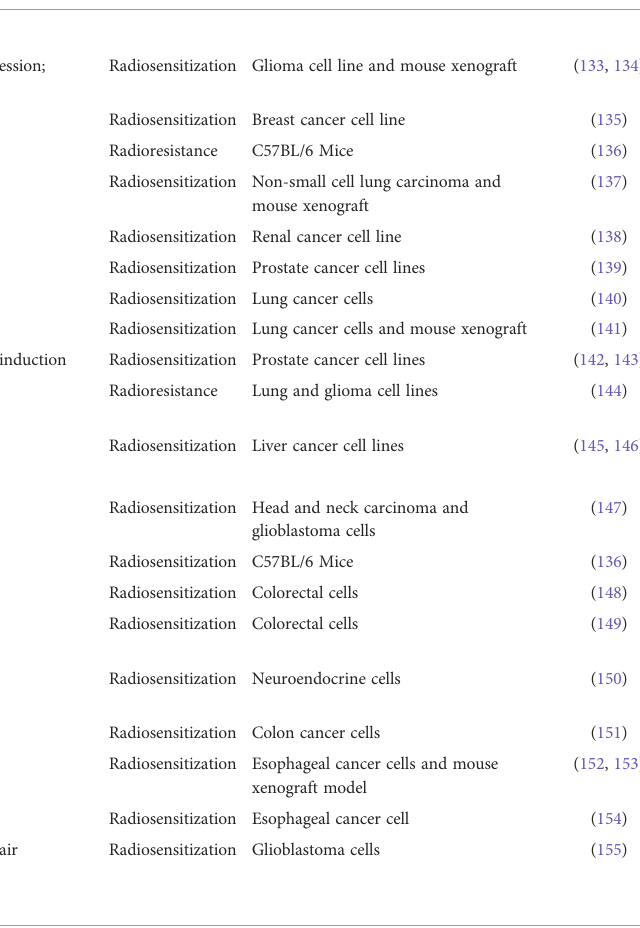
TABLE 1 Preclinical studies involving Autophagy modulators, the molecular mechanism they employ and, their effect on response to RT. Autophagy Mechanisms reported in the study modi fi er